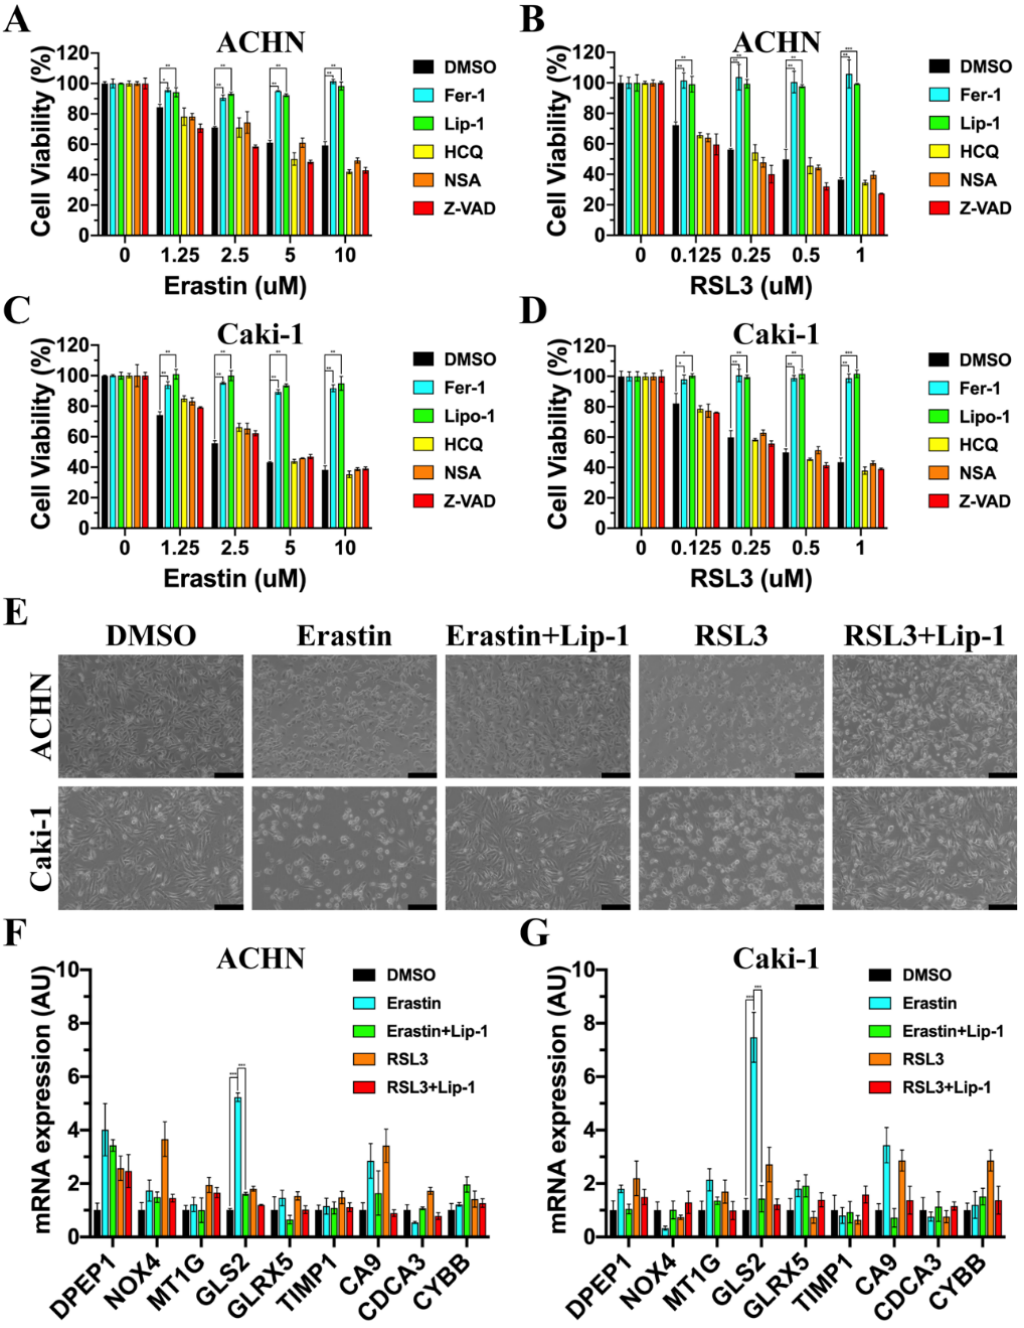
Figure 7. GLS2 was upregulated during ferroptosis. ( A , B ) ACHN cells were treated with various concentrations of erastin (12 h) or RSL3 (6 h) with or without Fer-1 (1 µ M), Lip-1 (1 µ M), HCQ (20 µ M), NSA (1 µ M), Z-VAD (20 µ M). ( C , D ) Caki-1 cells were treated with various concentrations of erastin (12 h) or RSL3 (6 h) with or without Fer-1 (1 µ M), Lip-1 (1 µ M), HCQ (20 µ M), NSA (1 µ M), Z-VAD (20 µ M). ( E ) The cellular morphology of AHCN and Caki-1 treated with erastin (10 µ M, 12 h) or RSL3 (1 µ M, 6 h) in the absence or presence of Lip-1 (1 µ M). The scale bar represented 500 µ m. ( F ) The mRNA expression of nine FPDEGs in ACHN treated with erastin (10 µ M, 12 h) or RSL3 (1 µ M, 6 h) in the absence or presence of Lip-1 (1 µ M). ( G ) The mRNA expression of nine FPDEGs in Caki-1 treated with erastin (10 µ M, 12 h) or RSL3 (1 µ M, 6 h) in the absence or presence of Lip-1 (1 µ M). (* p < 0.05, ** p < 0.01, *** p <